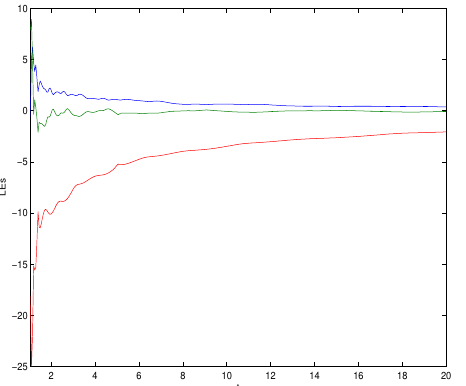
Figure 1. Lyapunov exponent dynamics from a Chen system (18).